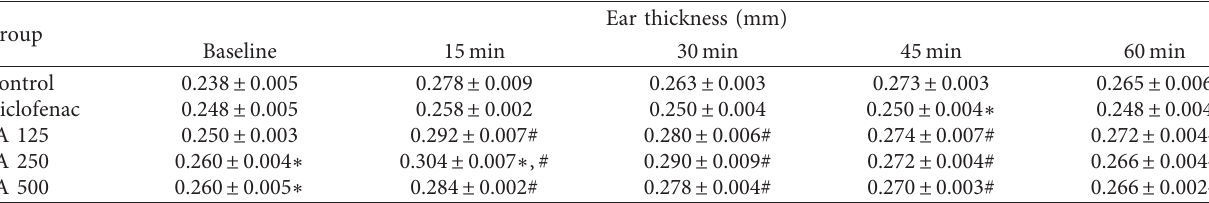
Table 3: Ear thickness (mm) express as mean ± SE.